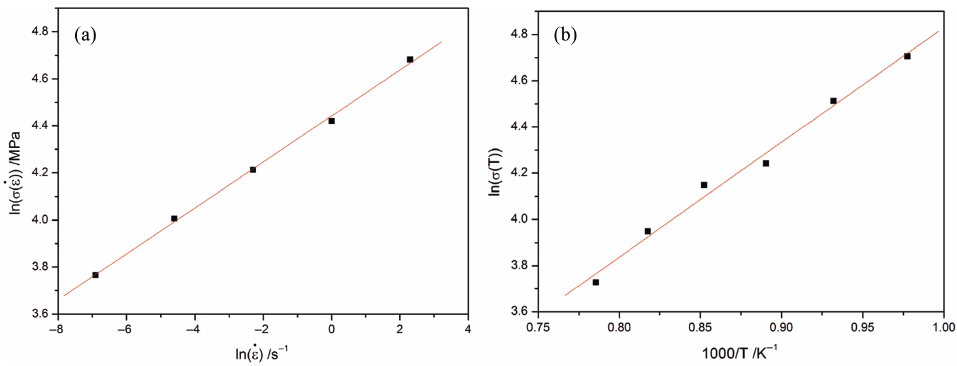
Figure 11: Relationship between (a) ln ð σ ð _ ε ÞÞ and ln ð _ ε Þ ; (b) ln ð σ ð T ÞÞ and 1,000 = T